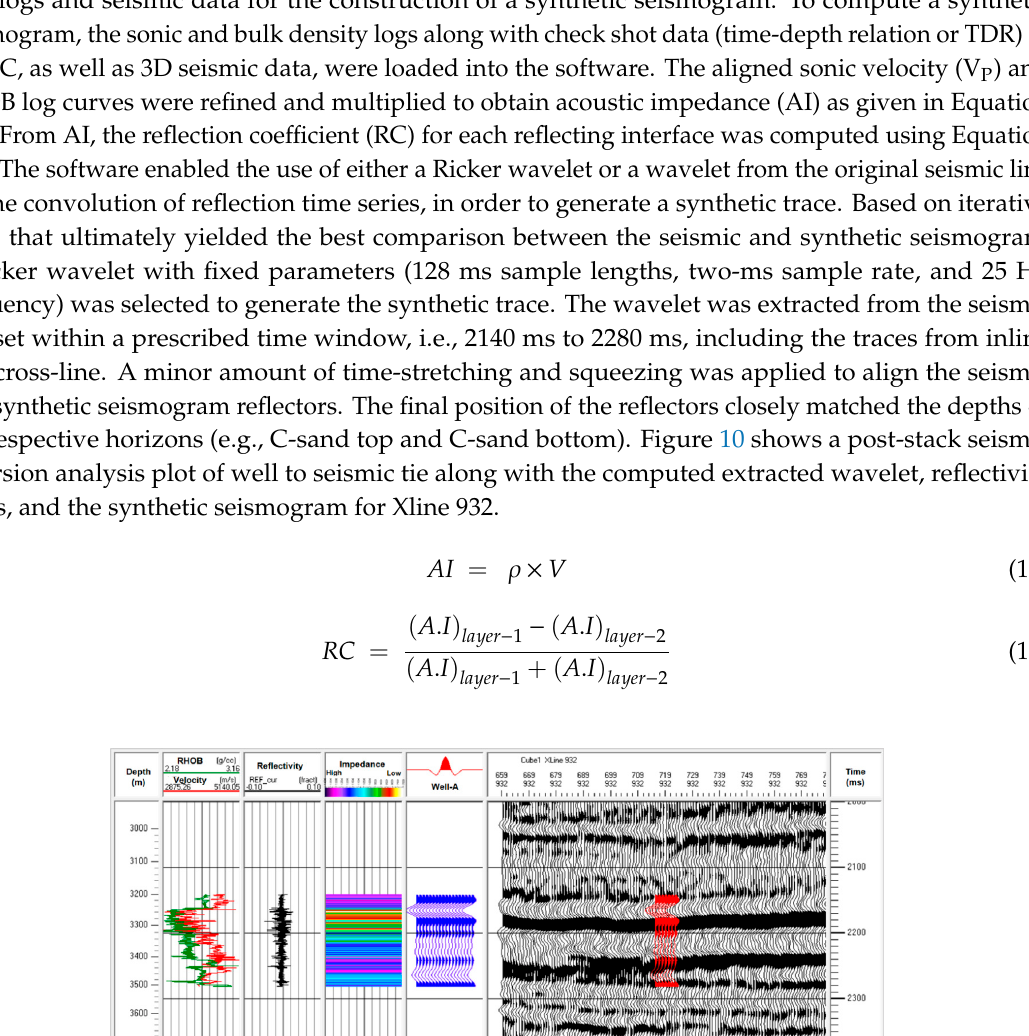
Figure 9. The petrophysical modeling and inversion of facies ( a ) 3D facies model, ( b ) cross-sectional view of the 3D facies model.